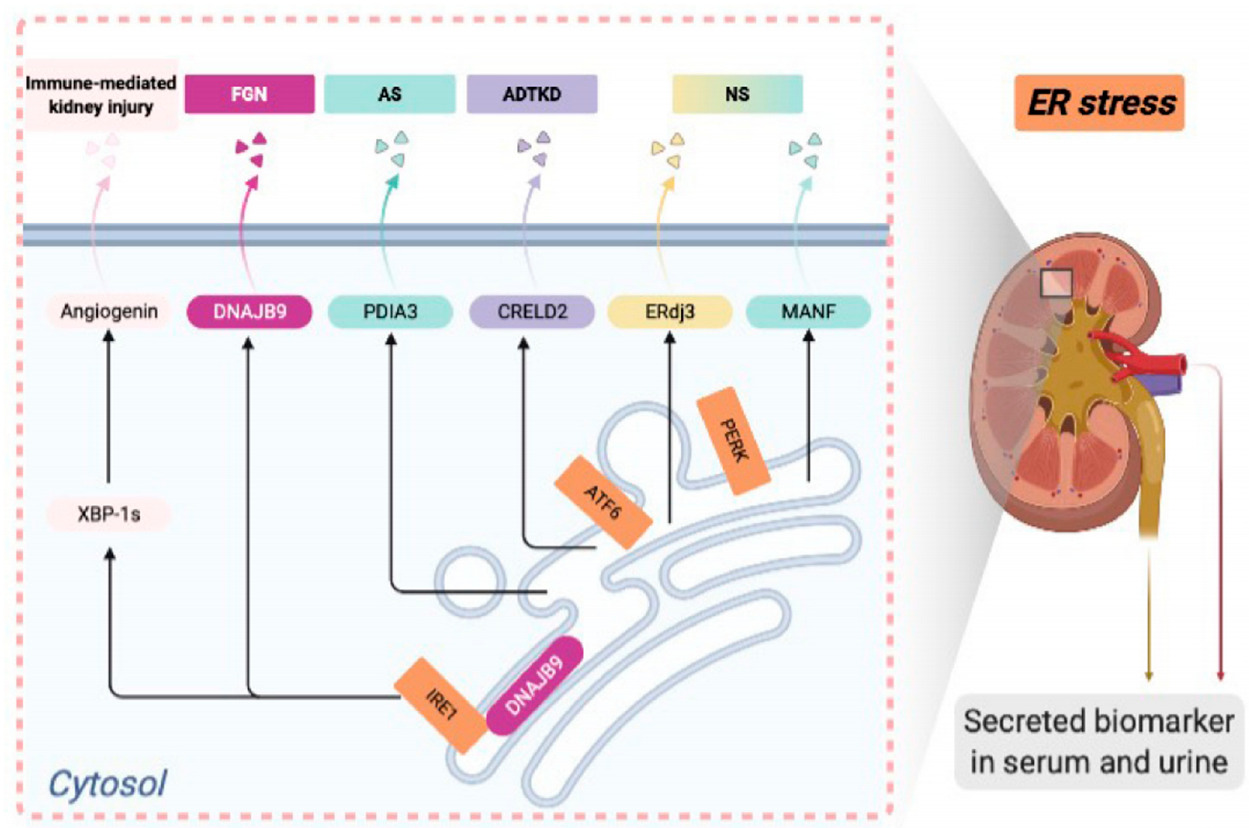
Figure 1. Endoplasmic reticulum (ER)-associated urinary or serum biomarkers in deep phenotyping of various rare kidney diseases.